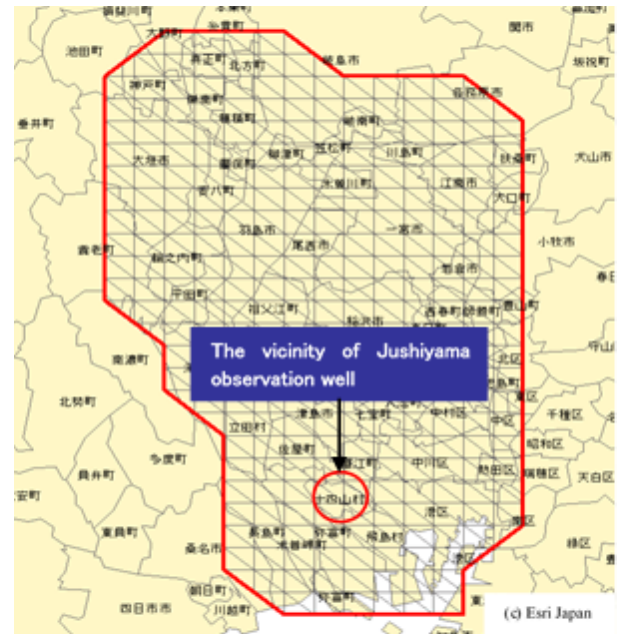
Figure 1. Analysis area.